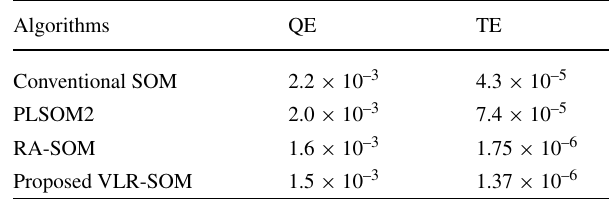
Table 3 Results for synthetic 2D data for 500 iterations for all